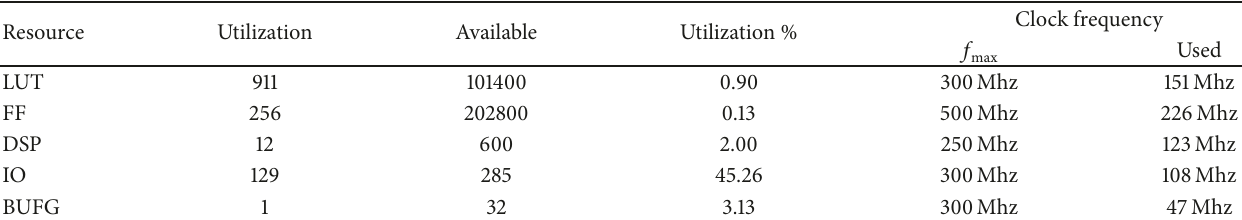
Table 8: Resource utilization of FONCS-4